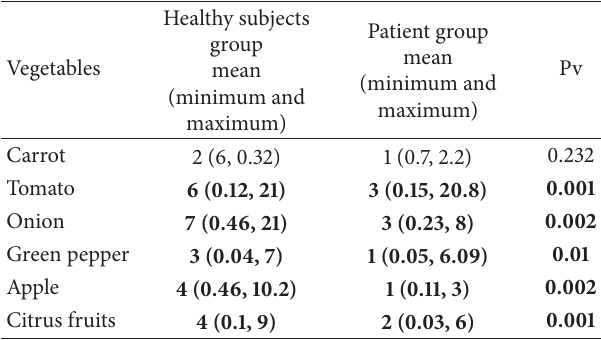
Table 4: Nutrient intakes of healthy group and patient group per